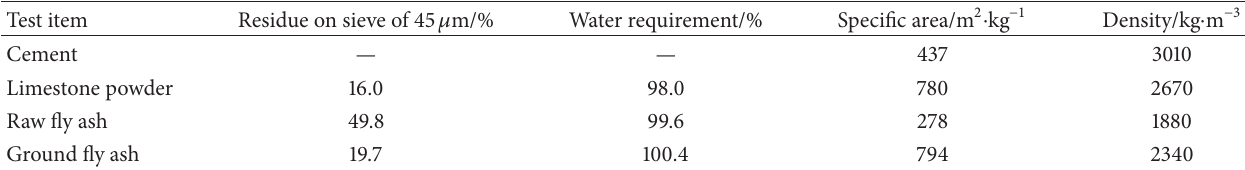
Table 2: Physical properties of mineral admixtures.